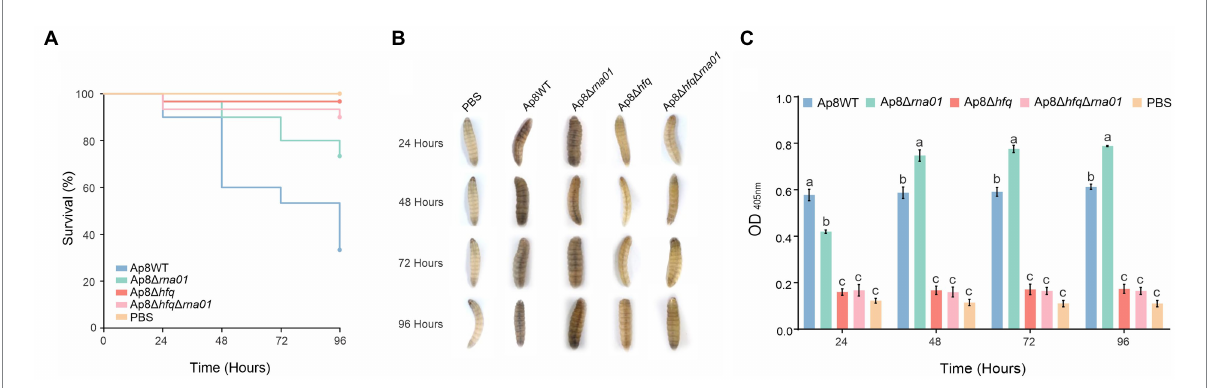
FIGURE 7 Effects of the deletion of the rna01 gene on Actinobacillus pleuropneumoniae virulence. (A) Killing assay of Galleria mellonella ; (B) Visual observation of larval melanization through the course of the experiment (only living larvae are shown, since dead larvae were black and dehydrated). (C) Optical density of larval hemolymph post-infection. Means with different letters are significantly different by the Tuckey’s test. The experiment was performed in